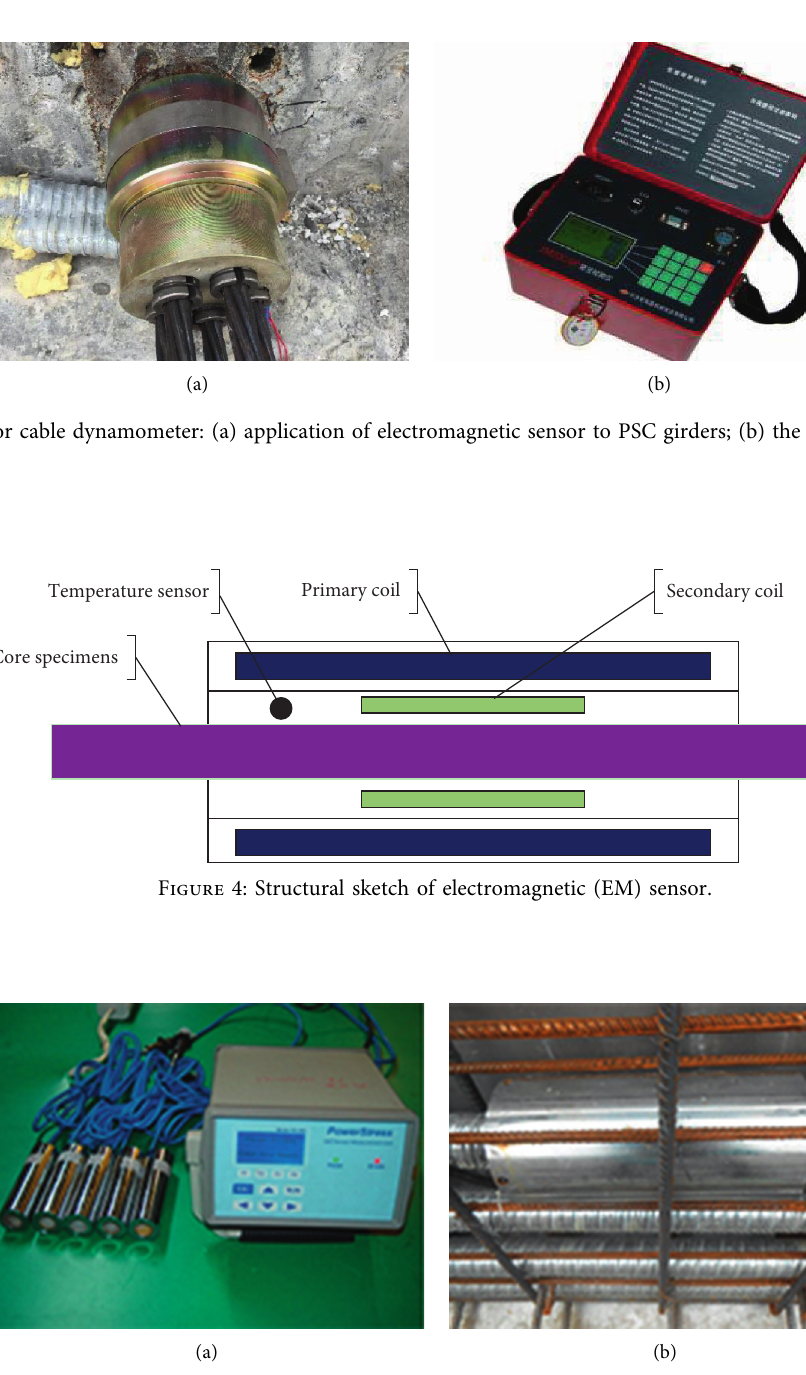
Figure 5: (a) Electromagnetic sensor and reader; (b) application of electromagnetic sensor to PSC